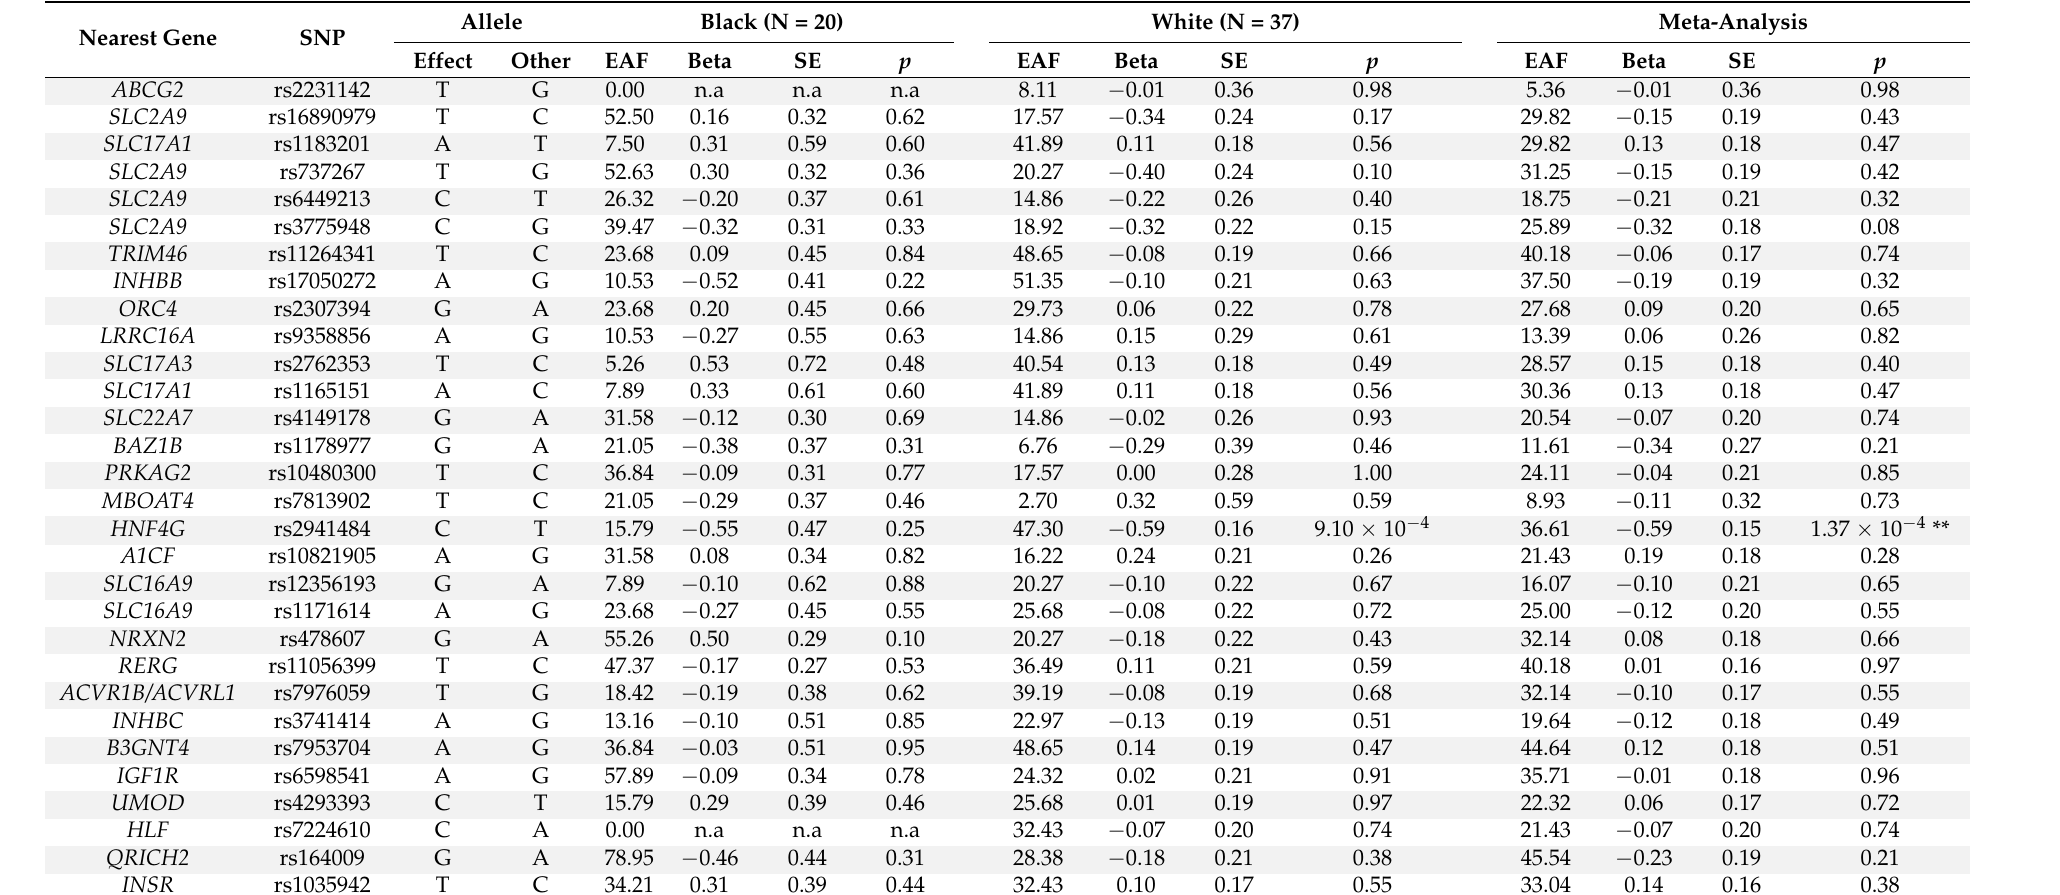
Table 3. Associations between SNPs and baseline serum